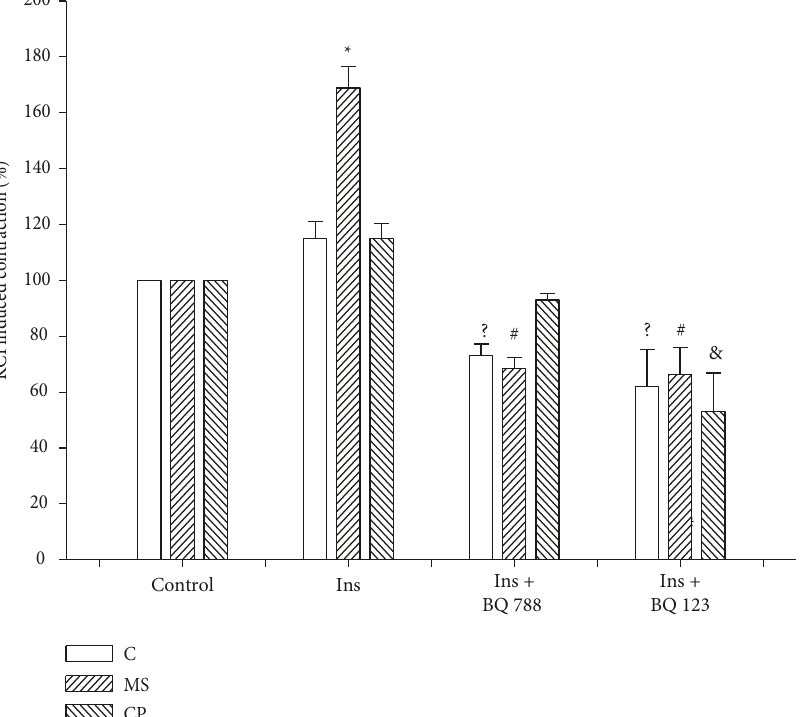
Figure 8: Participation of endothelin and endothelin receptors ET A and ET B (by the use of 1 μ M of antagonist BQ123 and BQ788, resp.) in the presence of 50 μ U/mL of insulin in KCl (40mM)-contracted aortic rings. MS: metabolic syndrome rats that ingested sucrose solution during six months; CP: critical period animals that ingested sucrose solution during postnatal days 12 to 28. Control rats received tap water. Values of KCl-induced contraction without insulin were normalized to 100% with respect to values in Figure 6(b) (first set of bars). Values are means ± SEM; ∗ P < 0 . 001 MS versus C Ins and CP Ins; ? P > 0 . 001 versus C Ins; # P < 0 . 001 versus MS Ins; & P > 0 . 001 versus CP Ins. n �